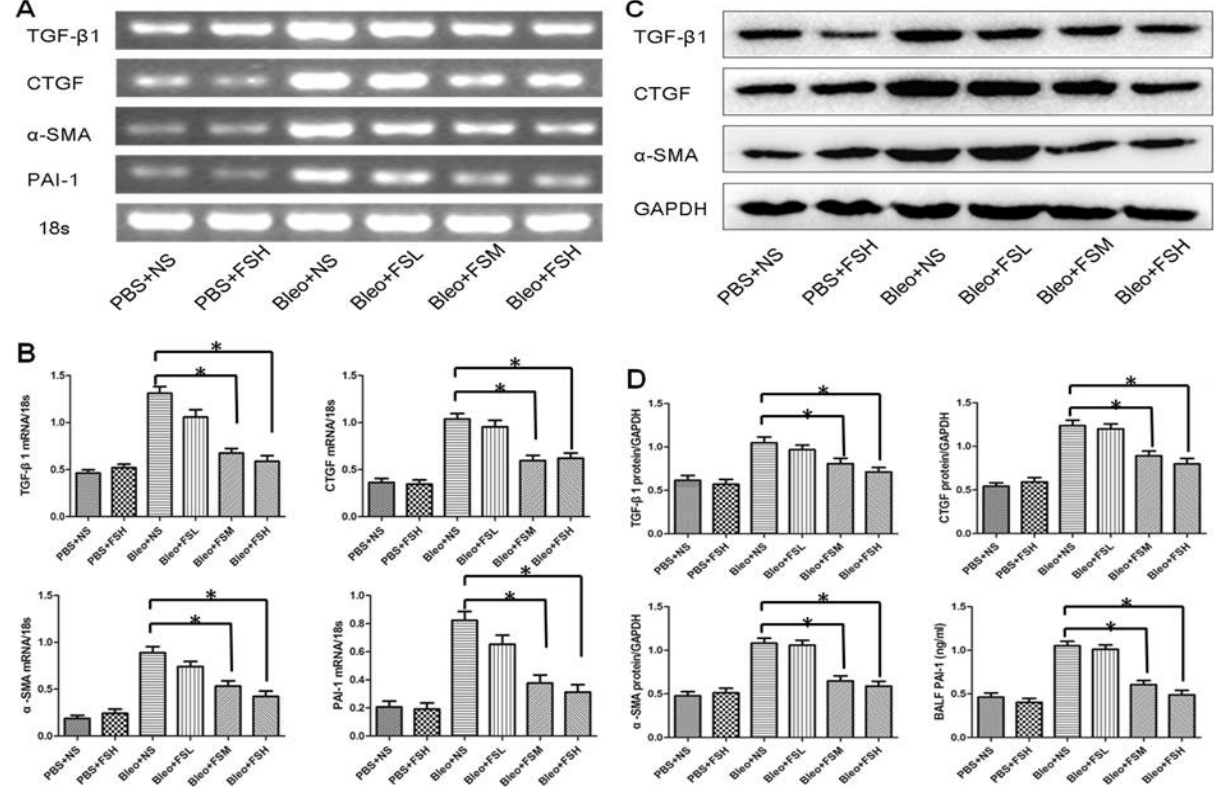
Figure 4. The levels of TGF- β 1, CTGF, α -SMA and PAI-1 mRNA expression and protein in the lung on day 21 after bleomycin administration. The mRNA expression was examined in lung tissue by semi quantitative RT-PCR, protein level of TGF- β 1, CTGF and α -SMA by Western blotting, while the level of PAI-1 protein in BALF was measured by ELISA. Results are expressed as means ± SEM ( n = 6). Statistical analysis was performed using one-way ANOVA followed by Tukey’s multiple comparison test (* p < 0.05).